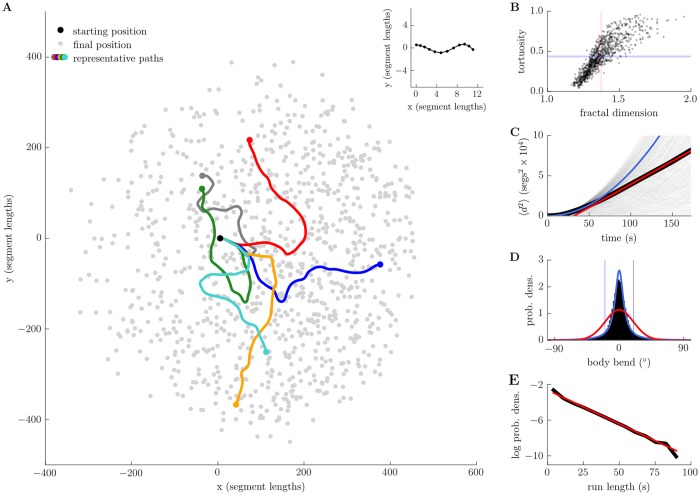
Deterministic exploration.A: dispersion of the centres of mass of 1000 simulated larvae, starting from almost identical mechanical initial conditions (overlayed in inset). B: tortuosity and fractal (box-counting) dimension for all 1000 paths indicate plane-filling behaviour (blue line = mean tortuosity, red line = mean dimension, see text; see S4 Fig for power law analysis of trajectory curvature and angular speed). C: mean-squared displacement (black line) shows transient quadratic growth (blue line) followed by asymptotic linear growth (red line, asymptotic diffusion constant ≈ 144segs2s−1; see also log-log plot, S5 Fig). D: distribution of body bends (black) with maximum likelihood von Mises (red) and wrapped Cauchy (blue) fits. E: distribution of run lengths with maximum likelihood exponential fit (red). Run lengths were calculated as duration between successive crossings of a threshold body bend (20°), indicated by blue lines in panel D. See S6 Fig for analysis of tail speed and head angular velocity. Parameters used to generate this figure are given in S5 Table.